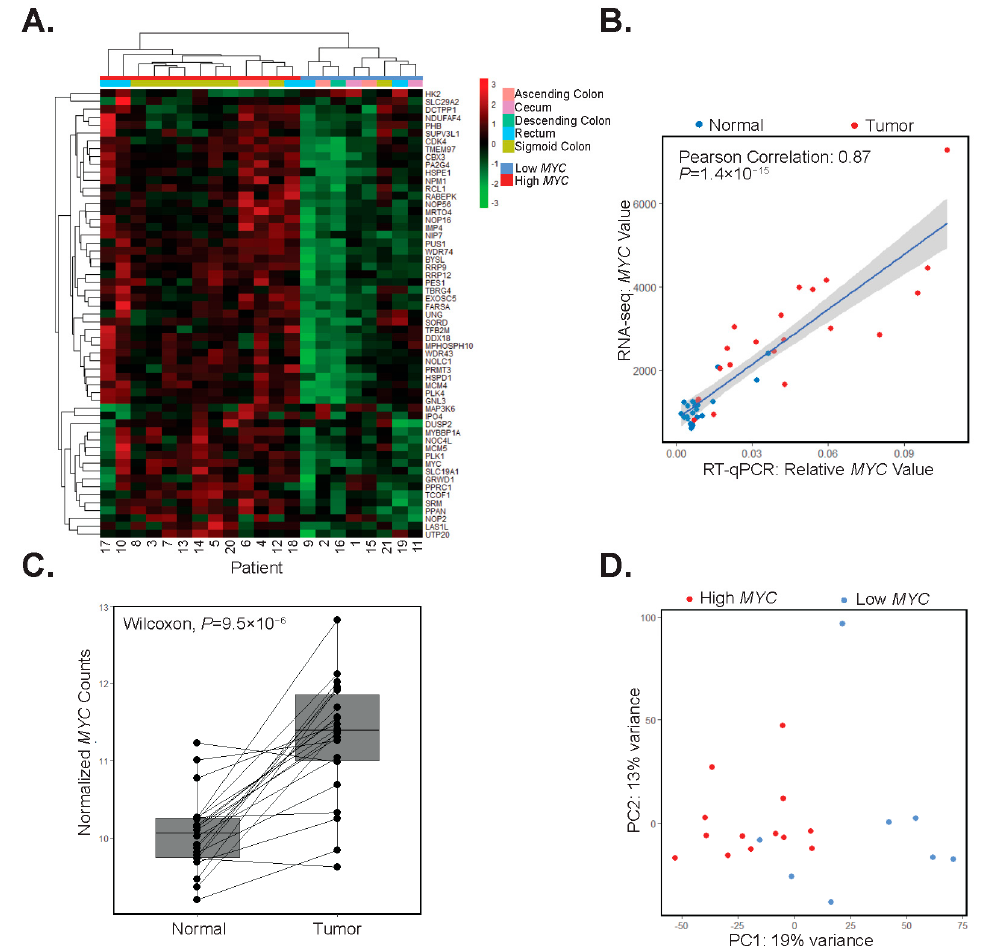
Figure 3. Differential MYC target gene expression clusters patients into two groups. ( A ) Hierarchical clustering of differential expression of MYC and its target genes in patient-matched tumors and adjacent colonic segments scaled by row. ( B ) RT-qPCR analysis of MYC and correlation with its expression in RNA-seq datasets in adjacent colonic segments (normal, blue points) and tumors (red points) (Pearson correlation 0.89, p = 1.4 × 10 − 15 ). ( C ) Boxplot of rlog normalized expression of MYC with lines connecting adjacent colonic segments (Normal) and tumor samples (paired Wilcoxon test, p = 9.5 × 10 − 6 ). ( D ) Principal component analysis of the top 5000 most variable genes in tumor samples with red points indicating high- MYC and blue points indicating low- MYC tumors.